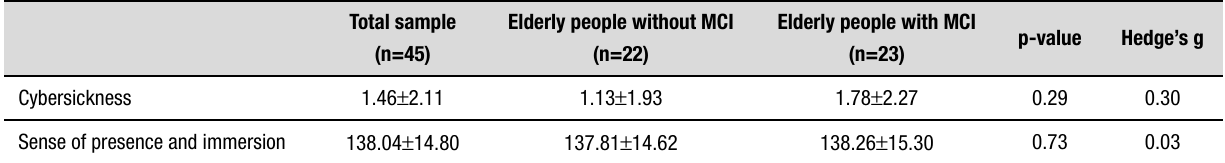
Table 2. Tolerability and sense of presence of the SOIVET-Route in the total sample of older adults and comparison between older adults with and without mild cognitive impairment.